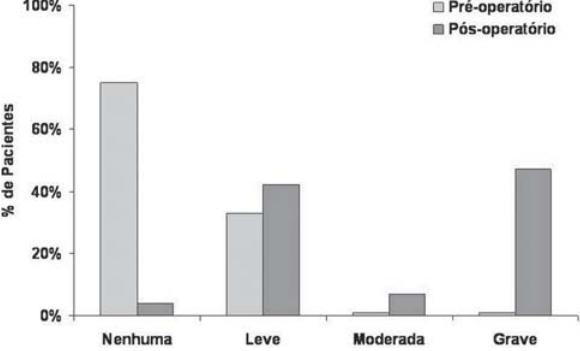
Fig. 2 - Comparação da gravidade do distúrbio ventilatório do pré-operatório para o sexto dia de pós-operatório